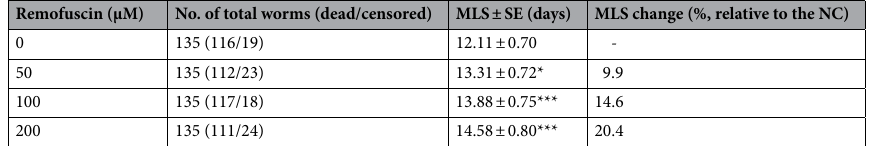
Table 1. The mean lifespans (MLSs) of C. elegans (N2) treated with various concentrations of remofuscin. All experiments were conducted three times independently. * p < 0.05, *** p < 0.001, log-rank test, compared with the NC (0 μM